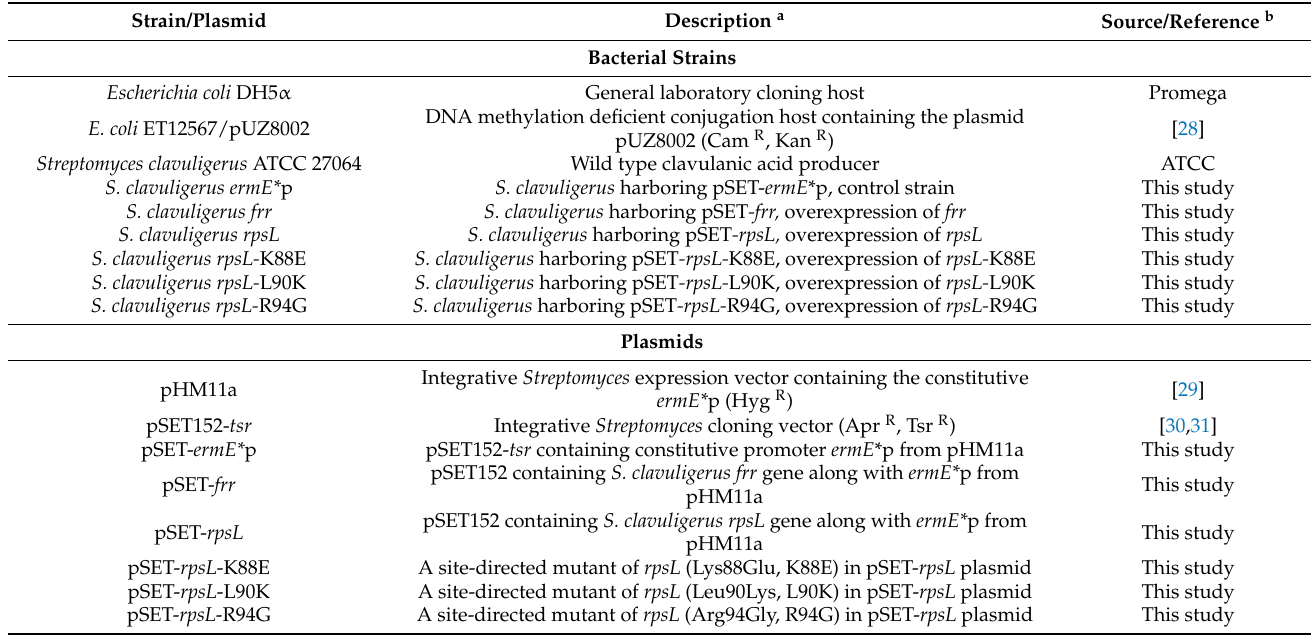
Table 1. Bacterial strains and plasmids used in the current study.